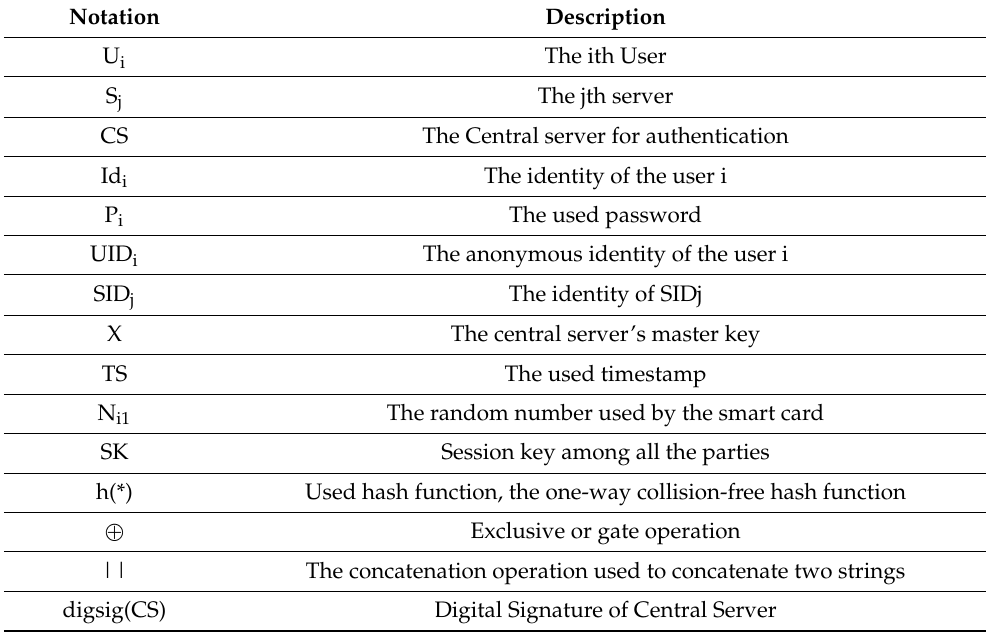
Table 2. Notation used in the authentication